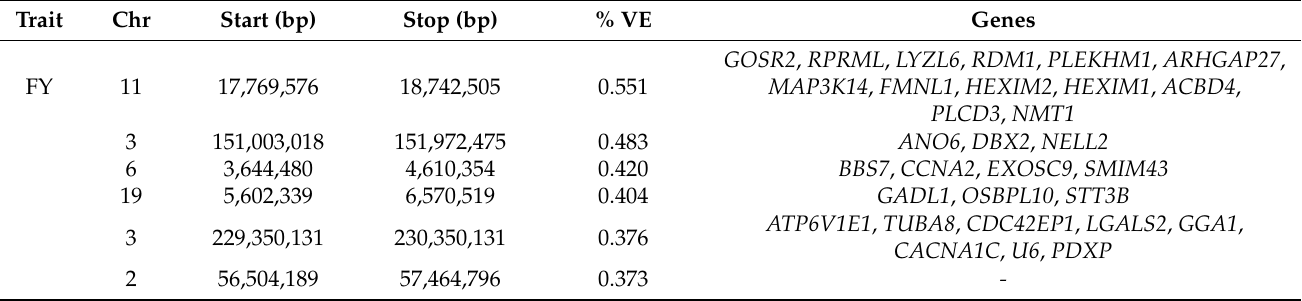
Table 3. Identification of genes based on additive genetic variance explained by top 10 window regions for milk fat yield and fat percentage